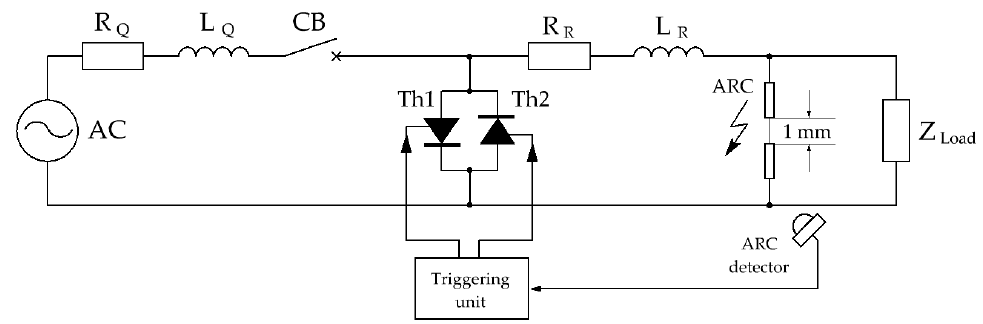
Figure 2. Arc eliminator test circuit (AE).